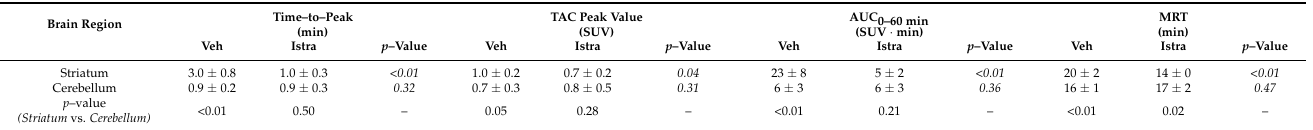
Table 2. Non–compartmental pharmaokinetic parameters derived from the time–activity curves of [ 18 F]FLUDA in target and reference regions in healthy CD–1 mice with vehicle (veh, n = 8) or istradefylline (istra, n = 4)